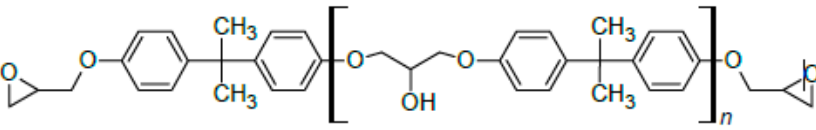
Figure 1. Structure of Epidian 5 epoxy resin [41].